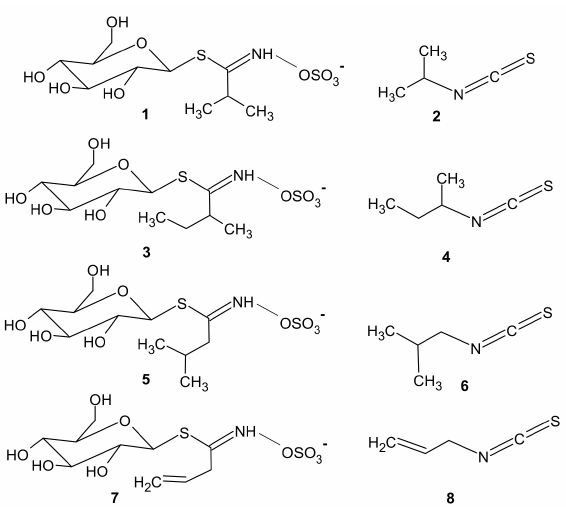
Figure 1. Glucosinolates (left) and isothiocyanates (right) previously identified in Sisymbrium officinale